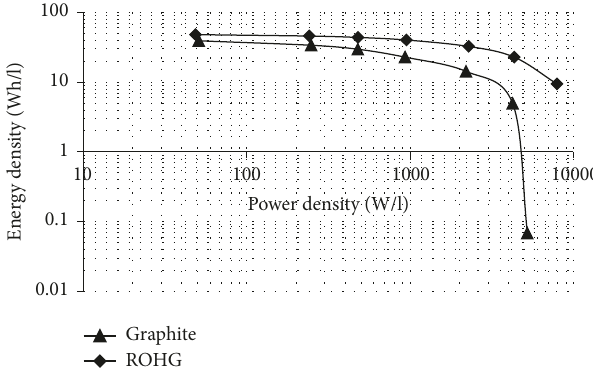
Figure 7: Ragone plot for Corning temperature processed hard carbon and